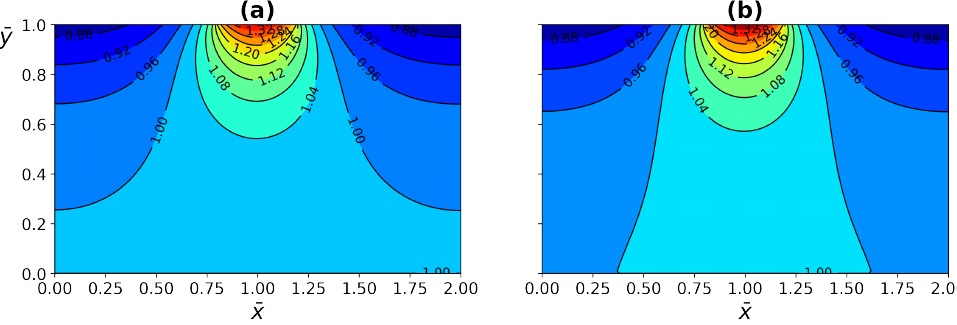
Figure 10. Comparison of temperature distribution between ( a ) WJ model, and ( b ) present work at dimensionless time. Just before the heat source was